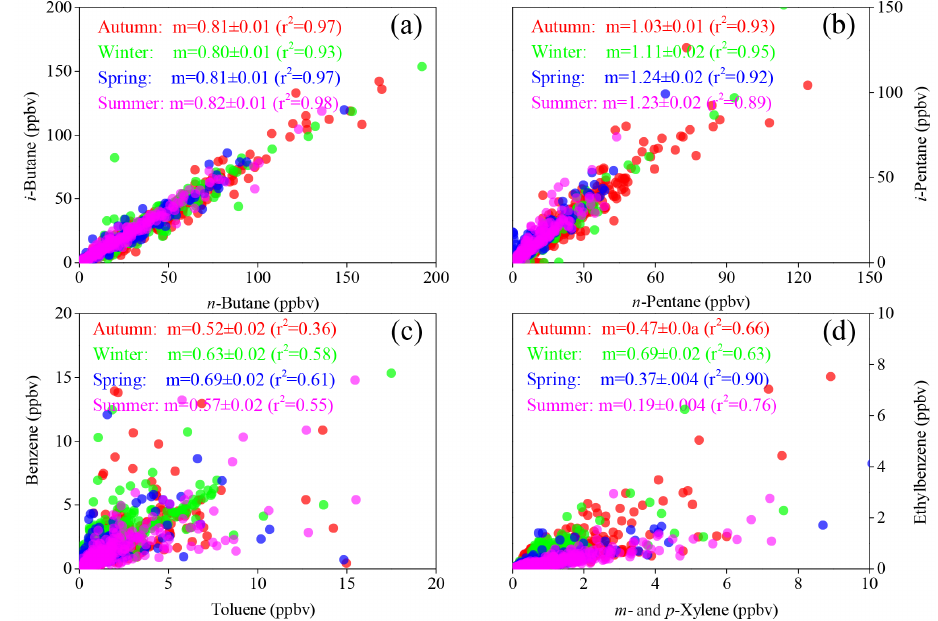
Figure 8. Correlations ( m = slope ± standard error ( r 2 )) between compounds with similar atmospheric lifetimes including i -butane /n - butane (a) and i -pentane /n -pentane (b) , and compounds with different lifetimes including benzene / toluene (c) and ethylbenzene /m - and p -xylene (d)